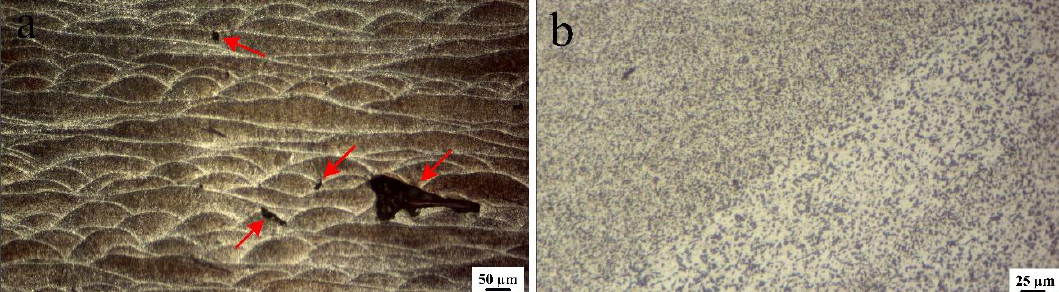
Figure 16. Optical microscope (OM) images of ( a ) large porosities in BM and ( b ) SZ of one-pass FSPed samples showing the absence of large porosities. The red arrows refer to the large porosities in BM ( a ).